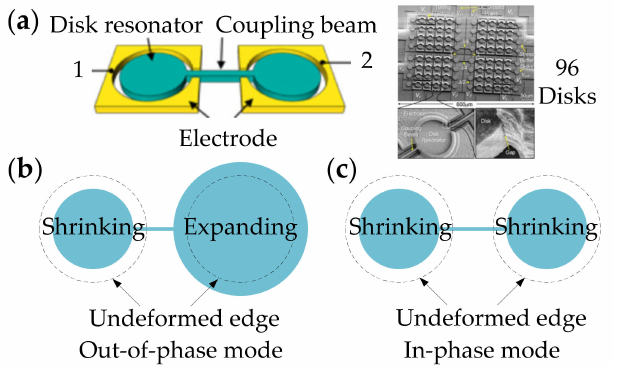
Figure 32. ( a ) Schematic and SEM image of a 2-DoF and 96-DoF coupled BAW disk resonator filter system; ( b ) Revised schematic of the out-of-phase radial contour mode shape; ( c ) Revised schematic of the in-phase radial contour mode shape. Adapted with permission from Ref. [80].